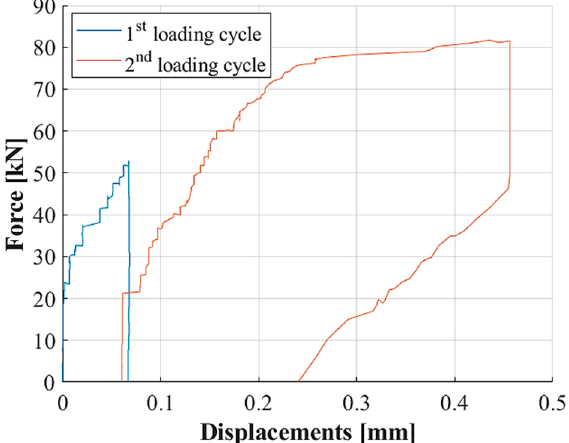
Figure 18. Force–strand slip curves for STR-02 of B8-P47/46.